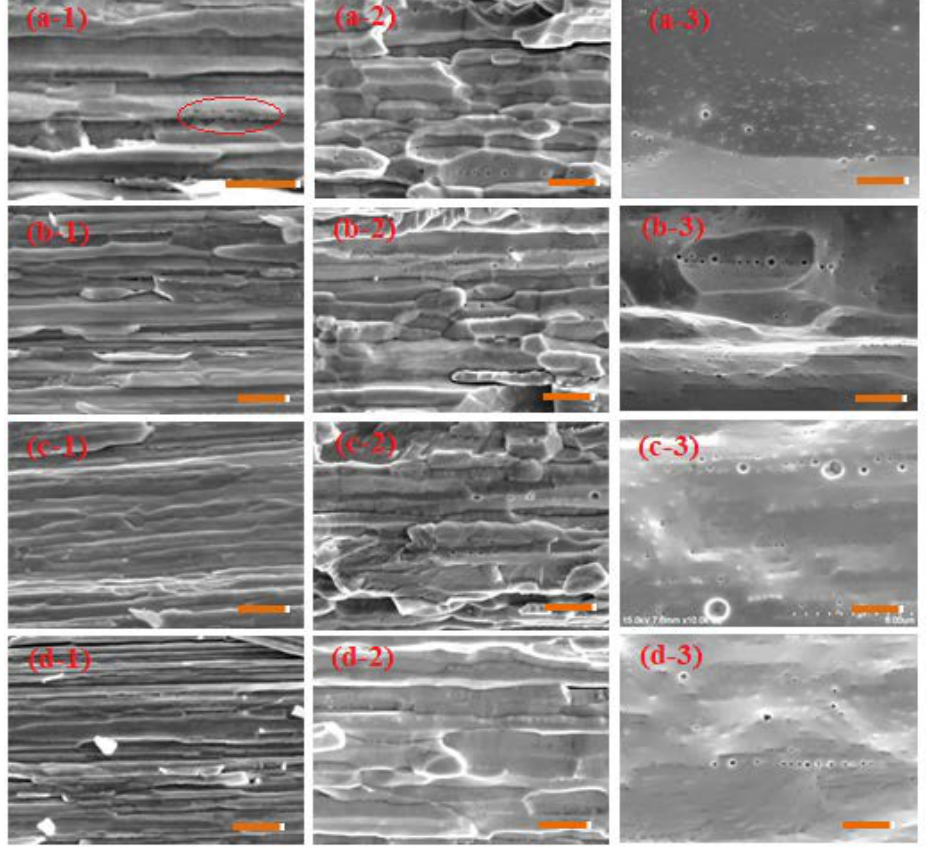
Figure 5. K tubes and bubbles of samples ( a ) 1#-0, ( b ) 1#-1, ( c ) 2#-0, and ( d ) 2#-1. Suffixes -1, -2, and -3 mean the as-worked state, recrystallization start state, and recrystallization end state, respectively. Bars are 2 μm. Table 3. K tube and bubble of Φ 0.39 mm tungsten wires at the stage of recrystallization.